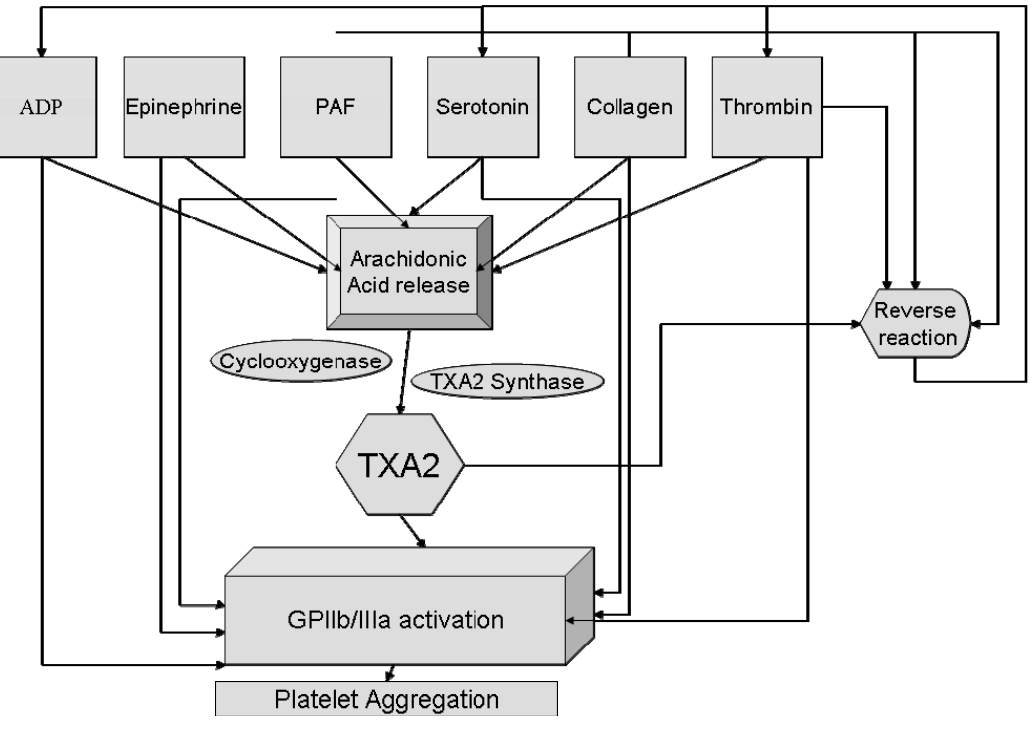
Figure 3. Various pathways for platelets activation. All the pathways lead to a common end point the GP IIb/IIIa receptors. (PAF: platelet activating factor, TXA ) (adapted from A 2